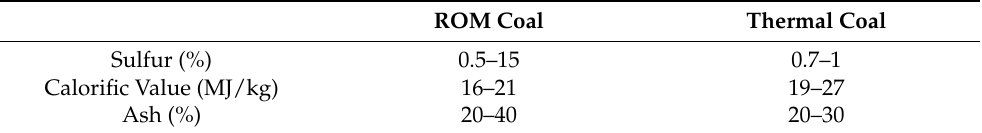
Table 1. South African ROM coal characteristics and market requirements for washed coal